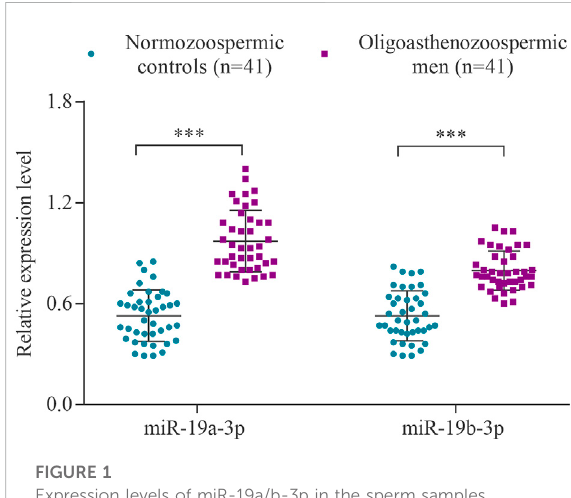
FIGURE 1 Expression levels of miR-19a/b-3p in the sperm samples collected from men with oligoasthenozoospermia ( n = 41) and normozoospermia ( n = 41) as determined by RT-qPCR. Data were presented as the relative expression level 2 − ΔΔ Ct of oligoasthenozoospermic and normozoospermic men. The p -value was calculated using an unpaired two-tailed Student ’ s t-test and p < 0.05 was considered statistically signi fi cant (*** p <